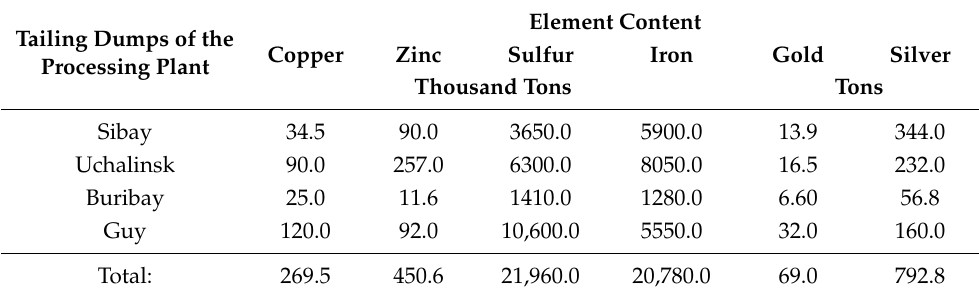
Table 1. The approximate amount of man-made formations of the Southern Urals.